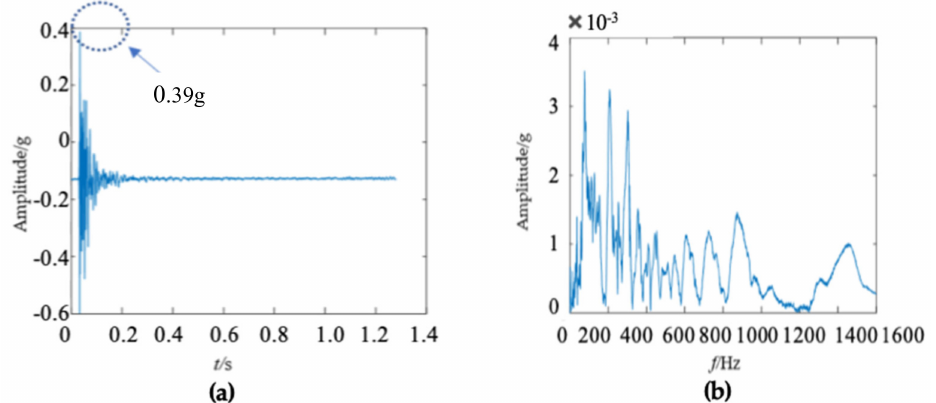
Figure 16. Vibration response signal and frequency spectrum of the wooden utility pole labeled as 265173: ( a ) the vibration response in the time domain and ( b ) the frequency spectrum.